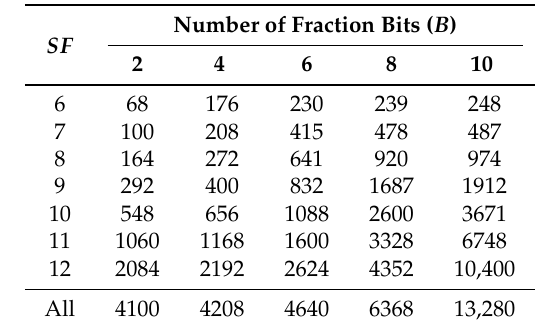
Table 5. Total number of samples ( N TX ) for a system with a length-17 filter, chirp segmentation, and quantization.